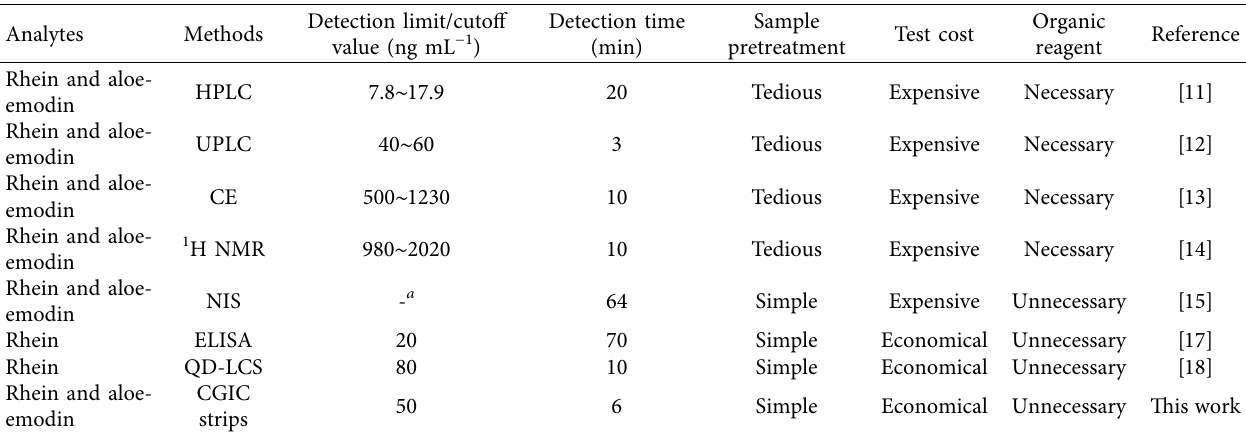
Table 2: Comparison of analytical performances of CGIC strips for rhein and aloe-emodin with other reported methods.